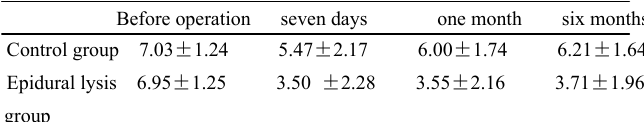
TABLE 2 - VAS scores before operation, seven days, one month, six months post operation.